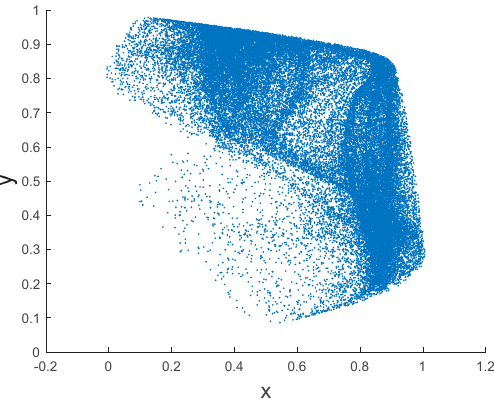
Figure 3. Attractor phase diagram of 2D logistic chaos.